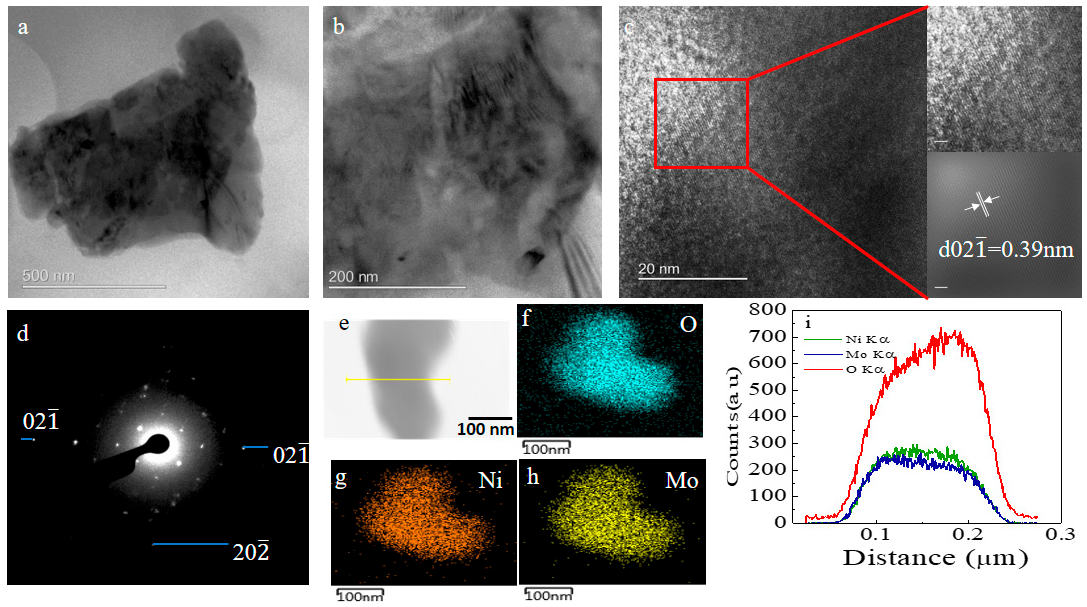
Figure 2. The transmission electron microscope (TEM) image for a single NiMoO 4 nanograin grown for 18 h at ( a ) low and ( b ) high magnification; ( c ) The high resolution transmission electron microscope (HRTEM) image with d spacing noted; ( d ) The selected area diffraction (SAED) pattern of the same sample showing respective planes. High angle annular dark field imaging scanning transmission electron microscope (HAADF-STEM) elemental mapping for a selected area showing ( e ) the electron with line mapping; ( f ) oxygen; ( g ) nickel; ( h ) molybdenum; and ( i ) line mapping, showing the counts of Mo, Ni, and O.